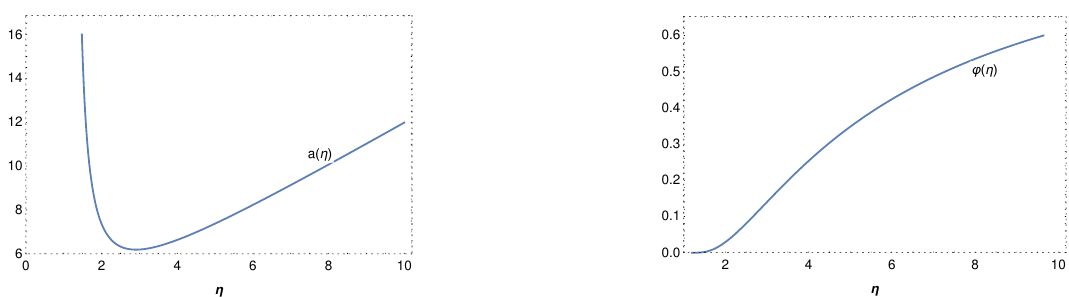
Figure 1. Behavior of the scale factor and scalar field in the case of the radiative fluid (Equations (28) and (29), lower sign) for ω = − 1.43.